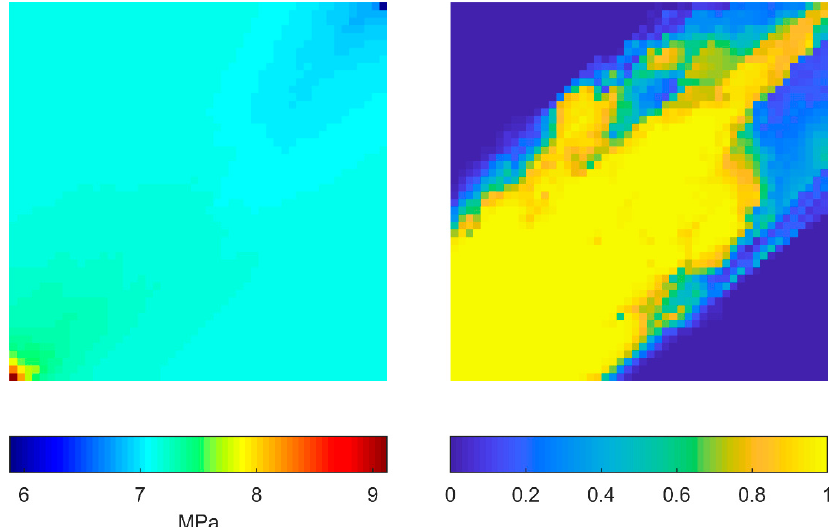
Figure 12. Reference pressure solution ( left ) and tracer concentration distribution after 2 PVI ( right ).